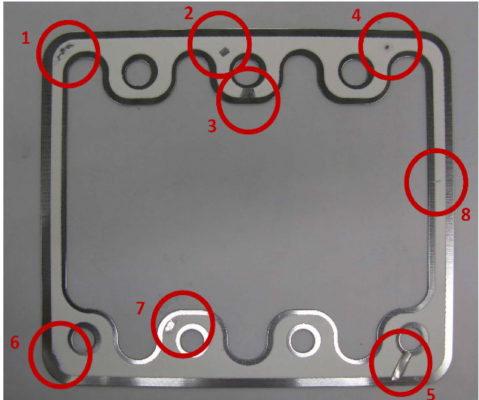
Figure 4. Photo of the defects prepared in the glass solder layer for evaluation of the NDT techniques before joining the cell element: 1. defective glass solder layer; 2. missing glass solder, about 3 × 3 mm 2 ; 3. missing glass solder, about 6 mm wide; 4. metal flake, about 1 × 1 mm 2 ; 5. strip of metal sheet, 3 mm wide; 6. reduced thickness of glass solder towards the edge; 7. defective glass solder layer; 8. metal flake, about 1 × 3 mm 2 .